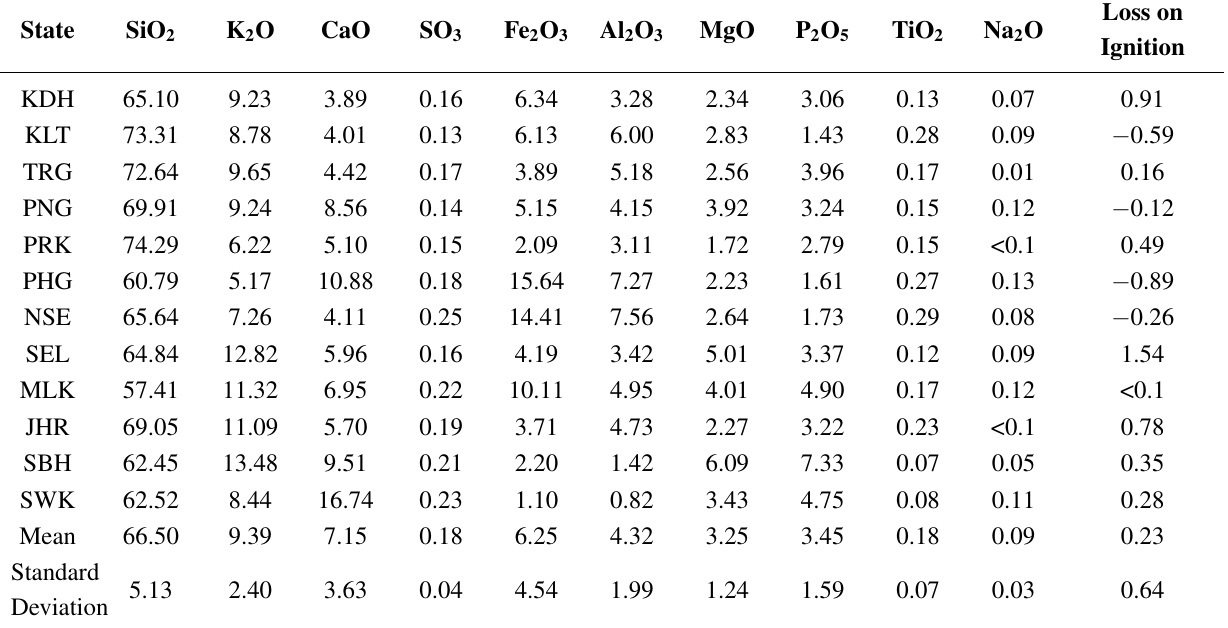
Table 5. Chemical composition of the POC samples from different